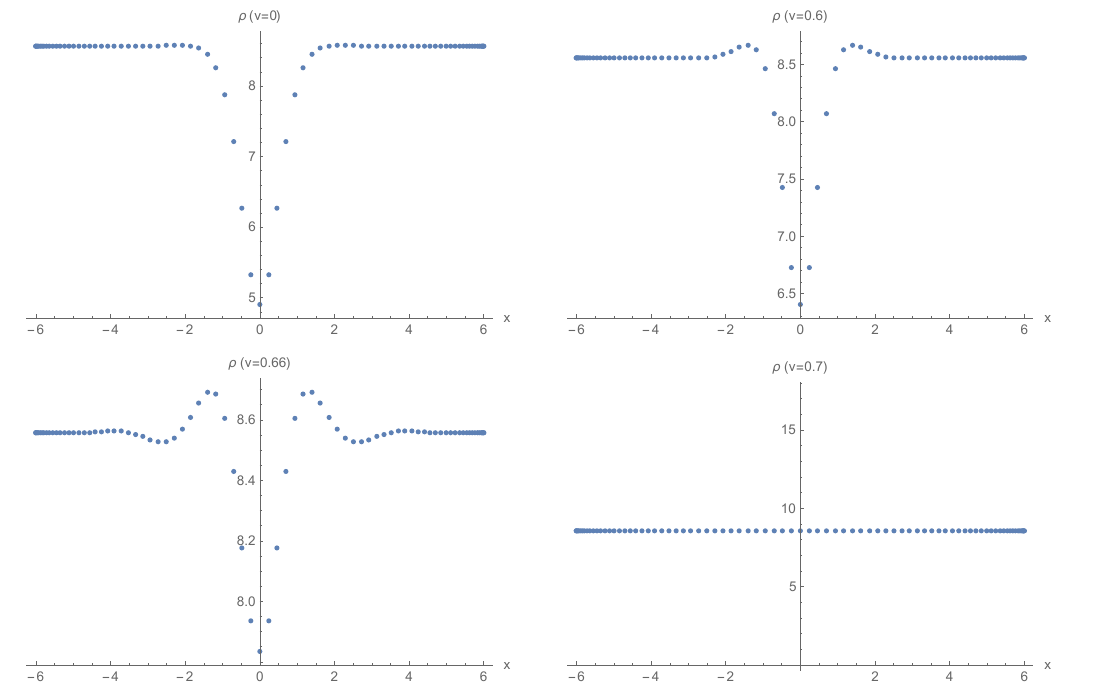
Figure 11 . The distributions of particle number density at di(cid:11)erent speeds ( v = 0 ; 0 : 6 ; 0 : 66 ; 0 : 7) of gray solitons with the chemical potential (cid:22) = 5 : 5 at standard quantization. The values of (cid:26) x =0 are in sequence 0.572601, 0.74807, 0.915534, 1 with the increasing